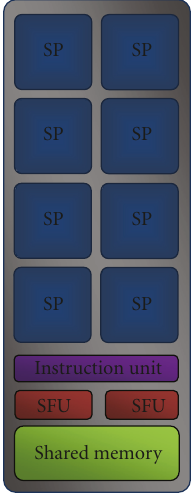
Figure 2: Streaming multiprocessors in